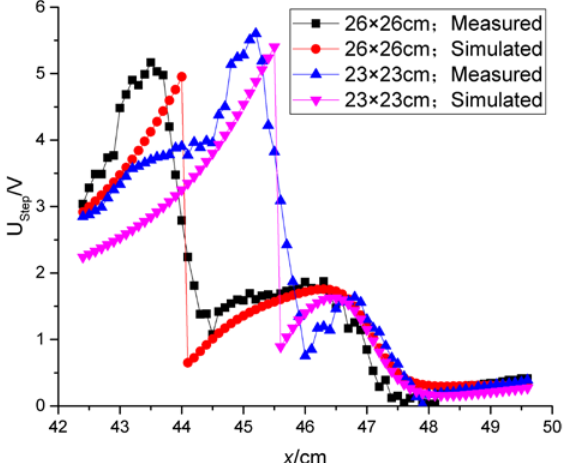
Figure 9. The difference in the simulation results and the experiment data.